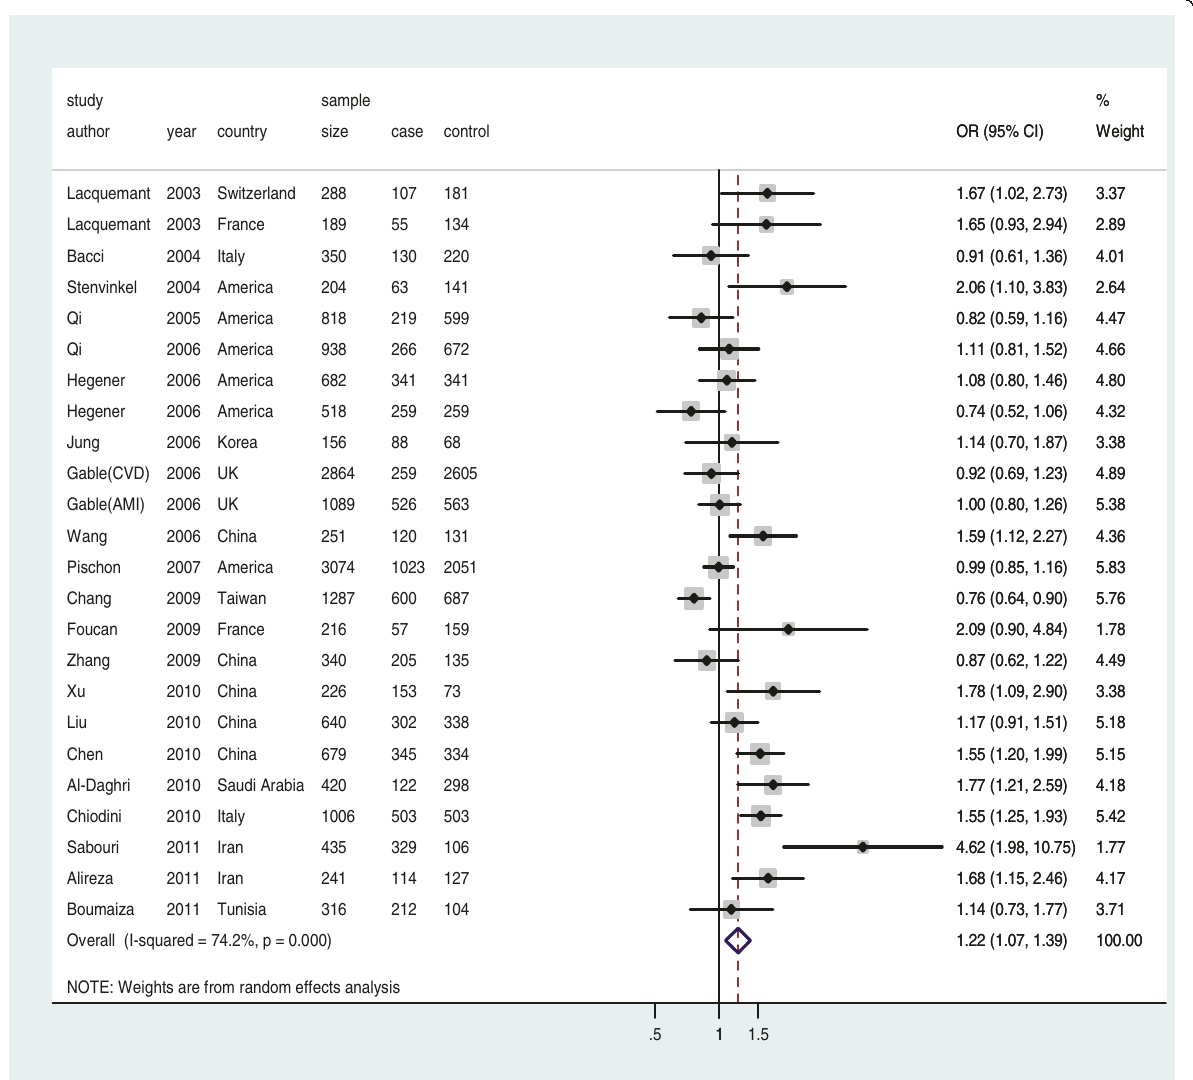
Figure 2 Meta-analysis for the relationship between rs2241766 and CVD risk. Year represents publish year. The solid squares represent odds ratios (ORs) from individual studies; the diamonds are shown as overall effect. The combined ORs along with their 95% CIs were in the contrast of G allele vs. T allele and estimated using the random-effects